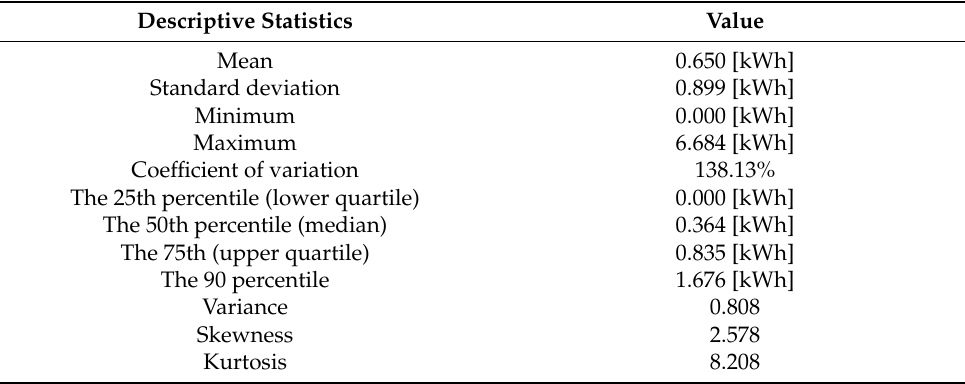
Table 1. Descriptive statistics for hourly electric energy generation.